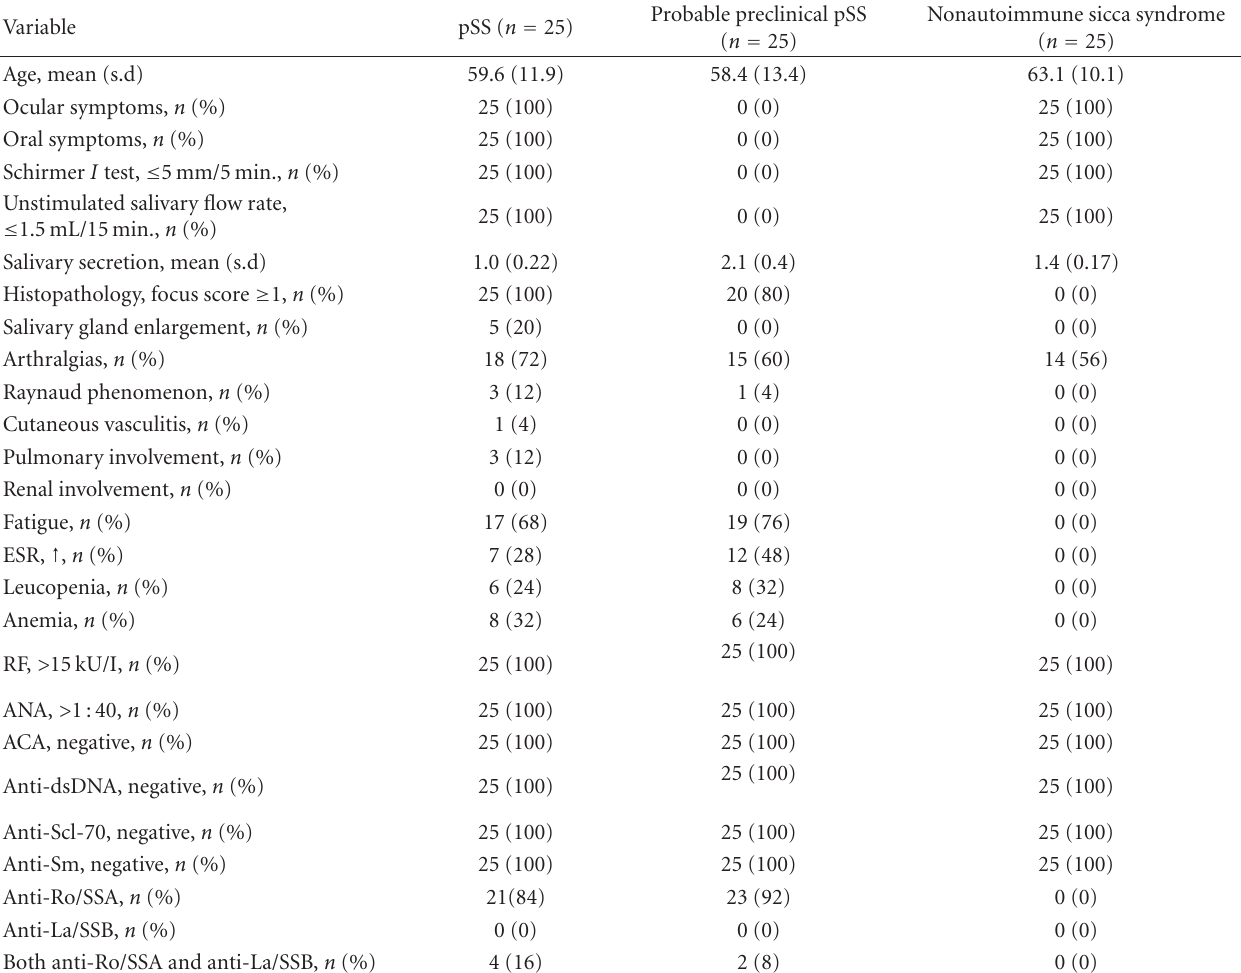
Table 1: Clinical and serologic characteristics of the